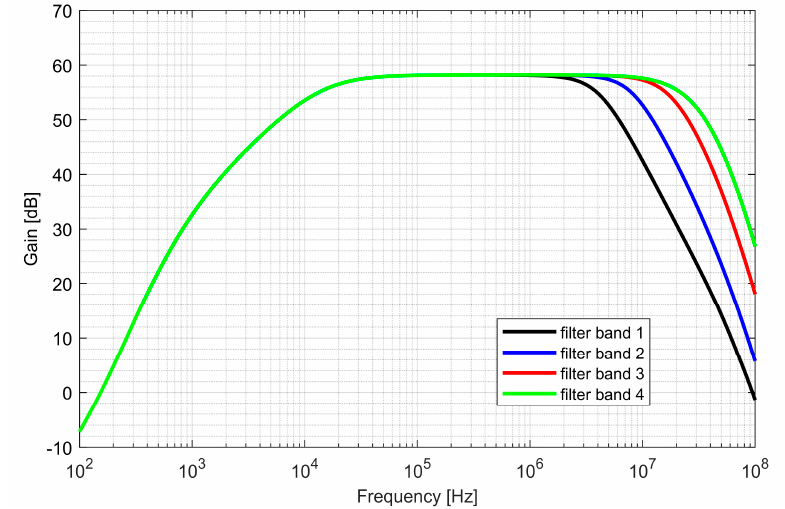
Figure 17. Gain characteristics of the intermediate frequency chain for different band settings.